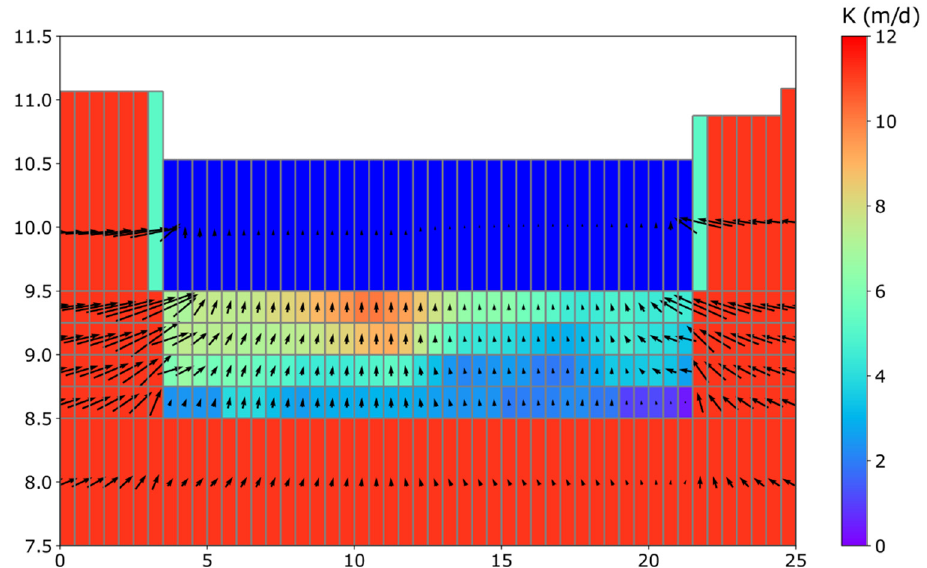
Figure 8. The Cross section through the riverbed at X = 17 m at the downstream section. Arrows indicate the direction and magnitude of groundwater flow through the aquifer and riverbed. Colour fill visualises the hydraulic conductivity of the riverbed, riverbank, and aquifer. Dark blue indicates constant head cells (i.e., the river water). Only the top six model layers are visualised.